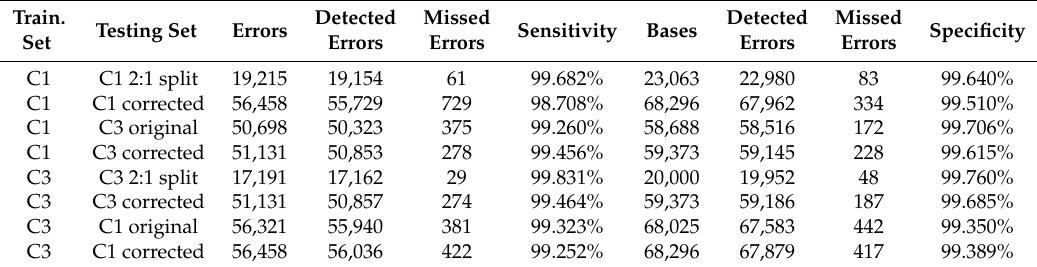
Table 1. Accuracy of error classification in metagenomics using artificial neural networks.